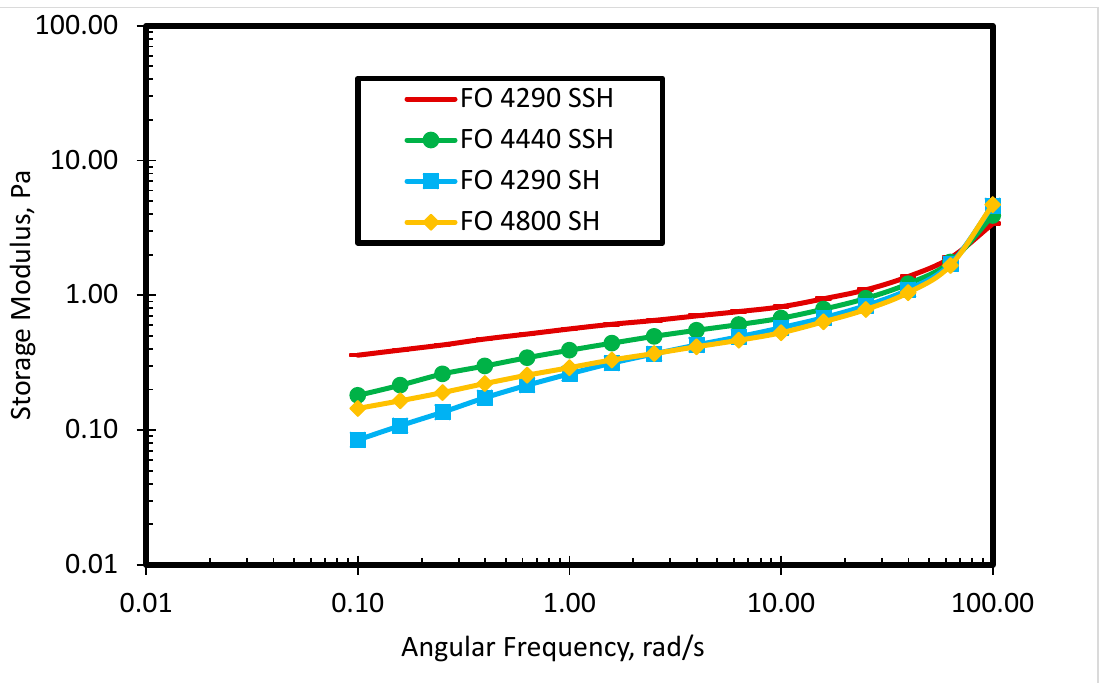
Figure 3. The storage modulus of commercial polymers in deionized water.